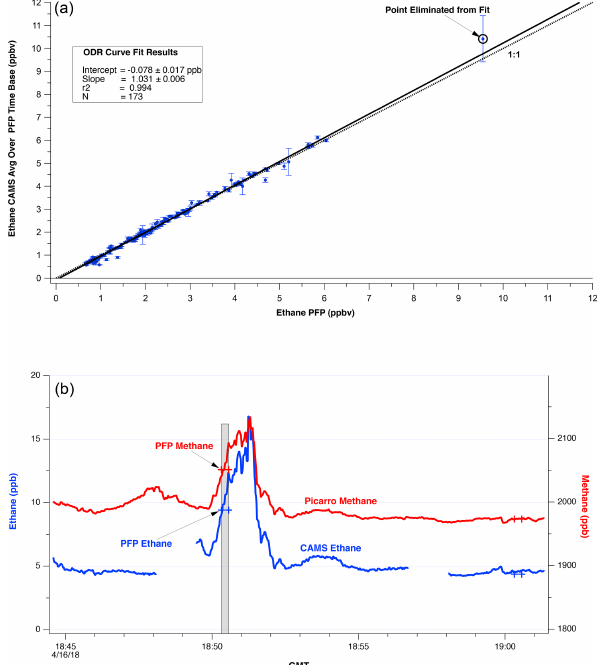
Figure 9. (a) Spring 2018 IV field deployment phase final com- parisons of CAMS average on PFP time base vs. PFP. (b) Tem- poral profile of ethane from the CAMS (blue lines) and PFP (blue crosses) measurements as well as PICARRO methane (red line) and PFP (red crosses) measurements. The gray shaded region shows the highly variable ambient results for the point eliminated in Fig.